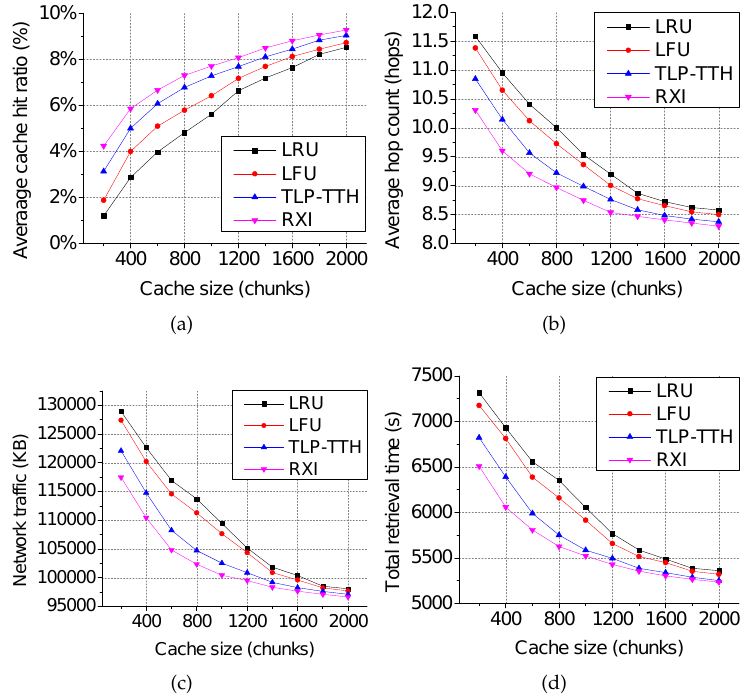
Figure 8. Simulation results of hybrid topology. ( a ) average cache hit ratio; ( b ) average hop count; ( c ) network traffic; ( d ) total retrieval